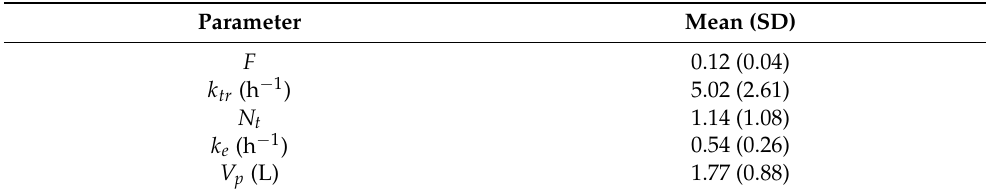
Table 2. Pharmacokinetic model parameter values for HUSTLE